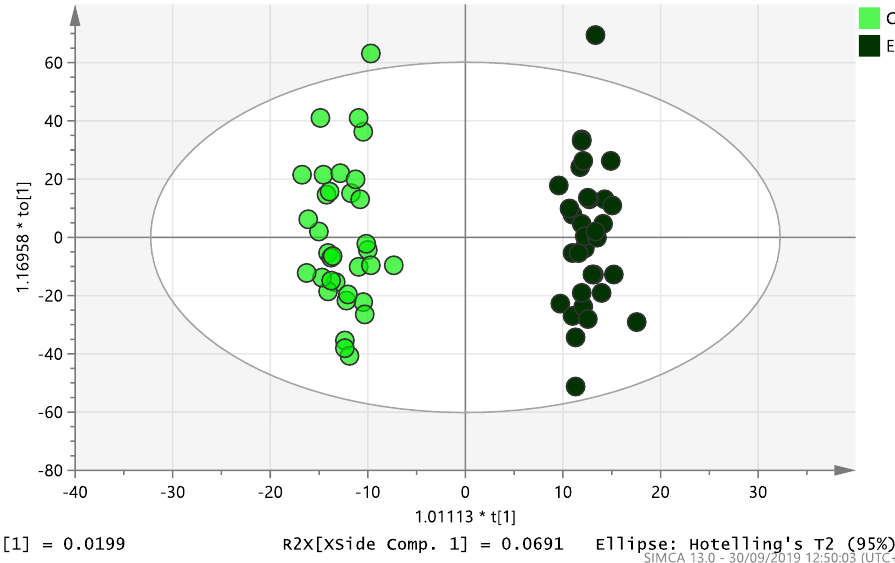
Figure 2. Multivariate analysis based on all detected ions from plasma samples: OPLS-DA score plot of control (C, n = 34) and endometrial cancer (E, n = 34), R2X(cum) = 0.298 and Q2(cum) = 0.296.